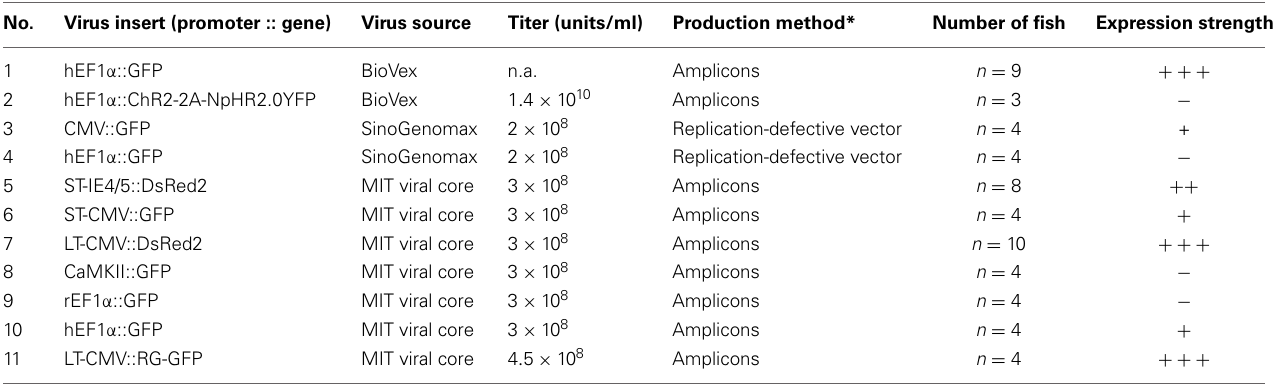
Table 1 | HSV-1 viruses and expression in the dorsal telencephalon of adult zebrafish.